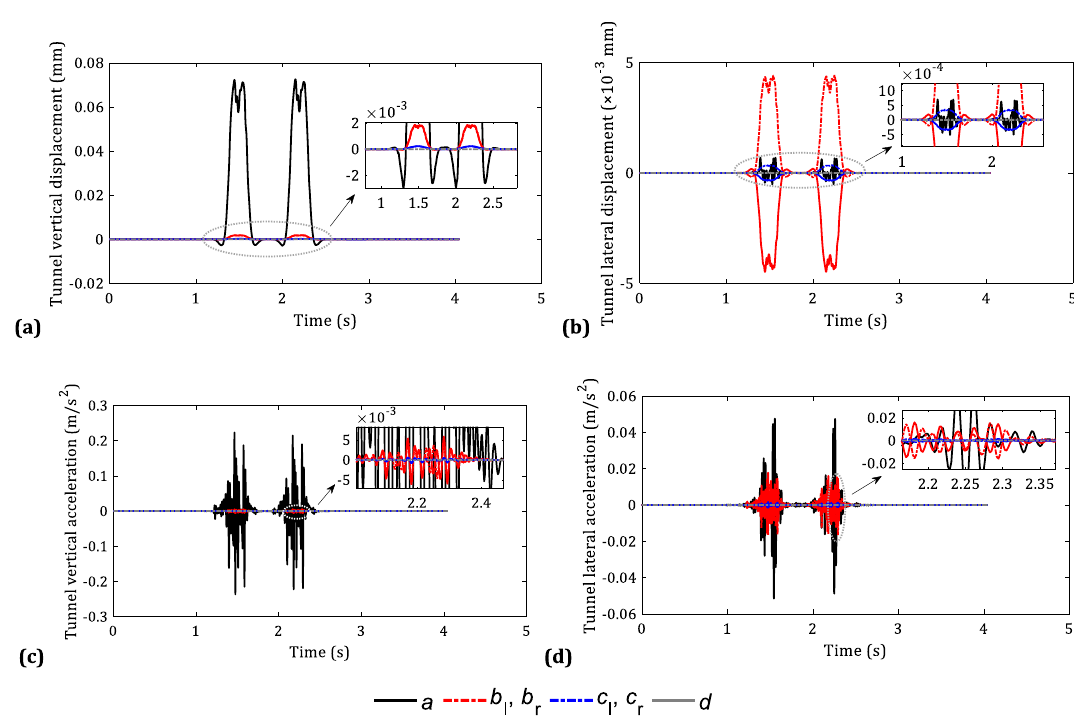
Fig. 17 Tunnel vibrations at different measurement points: a vertical displacement; b lateral displacement; c vertical acceleration; d lateral acceleration